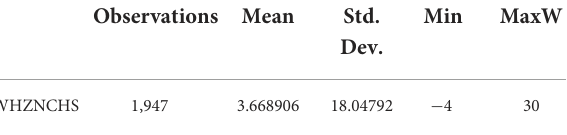
TABLE 2 Descriptive statistics of the explanatory variables.